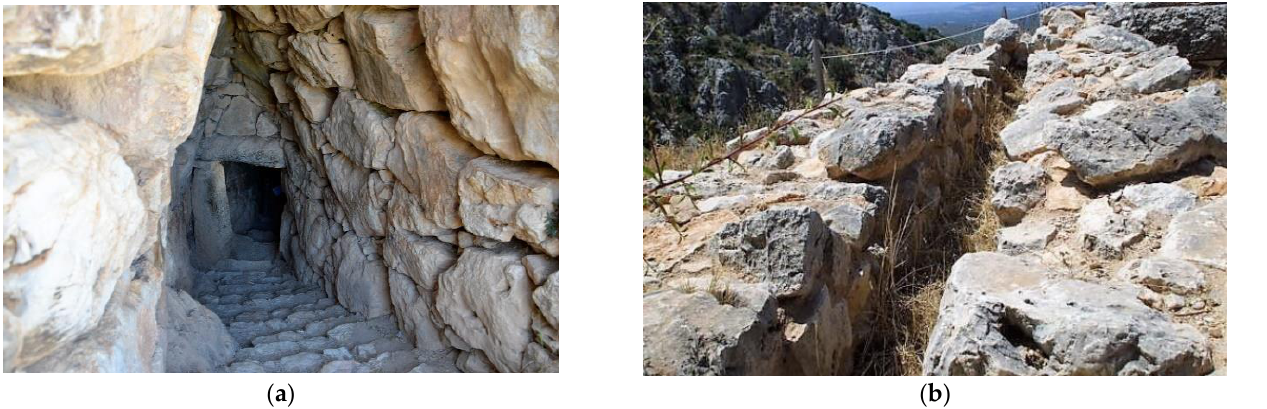
Figure 3. Remnants of water supply and sewerage system in Mycenae: ( a ) the underground cistern in Mycenae is an impressive engineering feat that allowed the citadel unlimited and secure water supply and ( b ) part of the central sewer/drain hillside outside of the Mycenae citadel (photos: A.N. Angelakis).